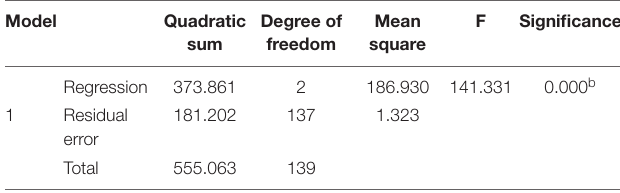
TABLE 3 | Correlation analysis.